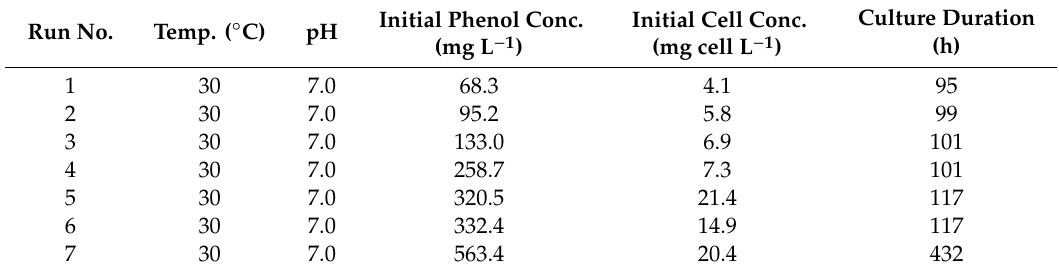
Table 1. Batch kinetic experiments to evaluate biokinetic